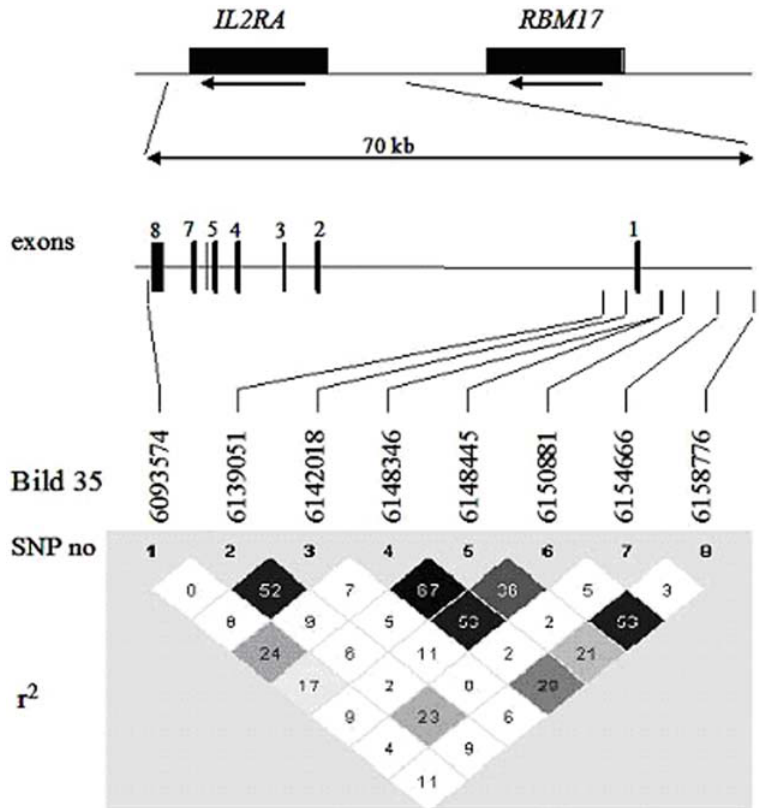
Figure 1. Schematic illustration of IL2RA locus showing the positions of the polymorphisms based on the NCBI Bild 35 and the linkage disequilibrium (LD) structure of the IL2RA gene as pairwise r 2 -values. The rs41295061 and the rs35285258 in this study correspond to ss52580101 and ss52580135, respectively in the T1D study. 13 rs35285258 is in complete LD with rs11594656 (r 2 =1) from the T1D study. 13 Both ss (submitted snp) numbers can be found as rs (reference snp) numbers in the SNPdb of